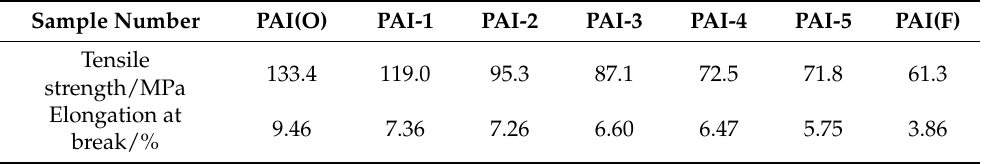
Table 4. Tensile strength and elongation at break of synthetic PAI